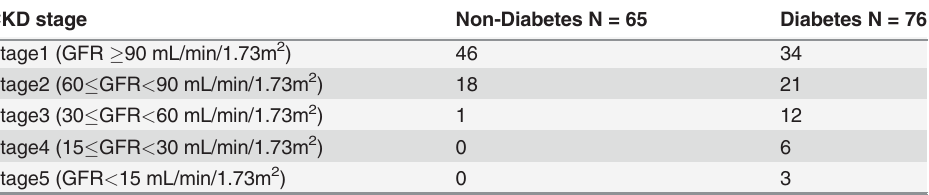
Table 5. Numbers of participants in non-diabetes and diabetes groups based on their CKD stages.